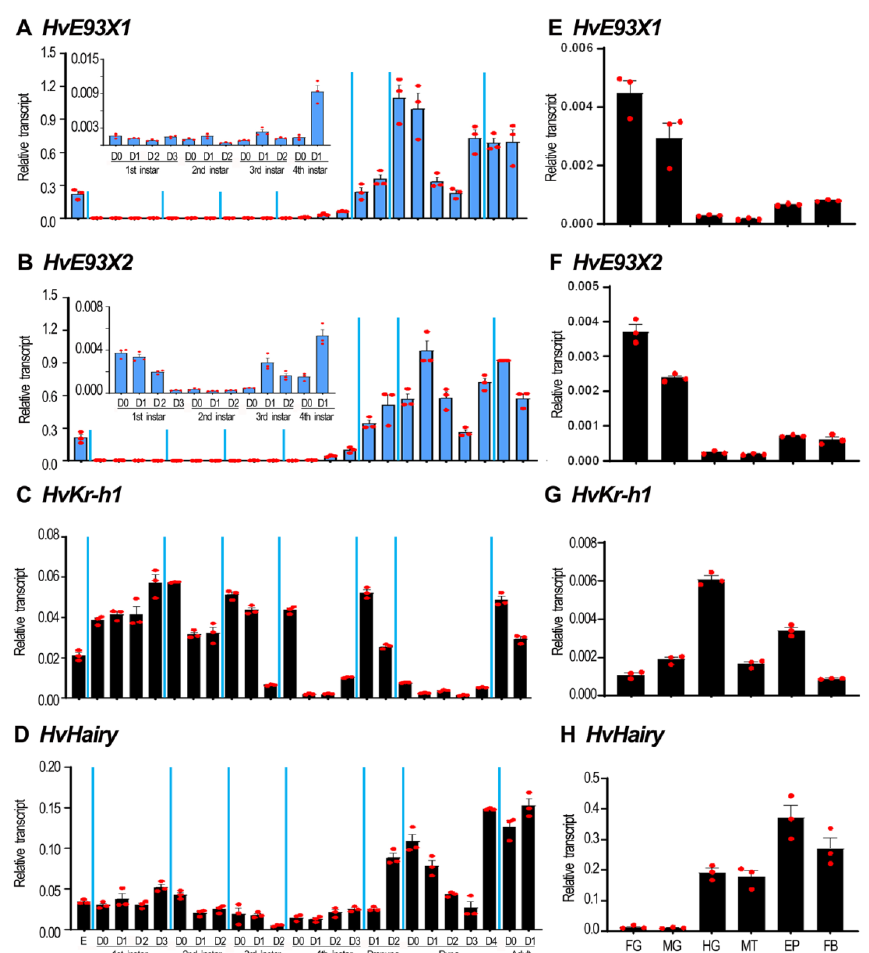
Figure 1. Temporal (A–D) and tissue (E–H) transcription patterns of HvE93X1 , HvE93X2 , HvKr-h1 and HvHairy in Henosepilachna vigintioctopunctata . RNA templates for temporal analysis were derived from eggs (3-day-old), the larvae from the first through the fourth instars, prepupae, pupae and adults (D0 indicated newly ecdysed larvae or pupae, or newly emerged adults), or from the foregut (FG), midgut (MG), hindgut (HG), Malpighian tubules (MT), epider- mis (EP) and fat body (FB) of the 2-day-old larvae for tissue-biased transcription analysis. The columns (2 −Δ CT values) represent averages, with vertical lines indicating SE. Inserts in panel A and panel B are amplified expression levels in 0-day-old neonates through 1-day-old fourth-instar lar- vae.